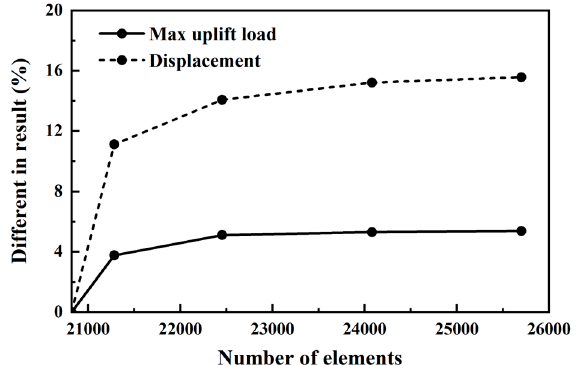
Figure 4. Selection of mesh .